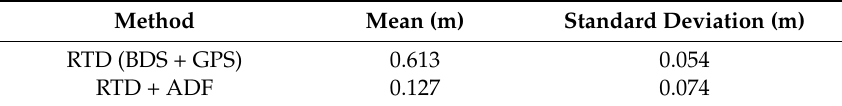
Table 2. Standard deviation of the pipeline position.